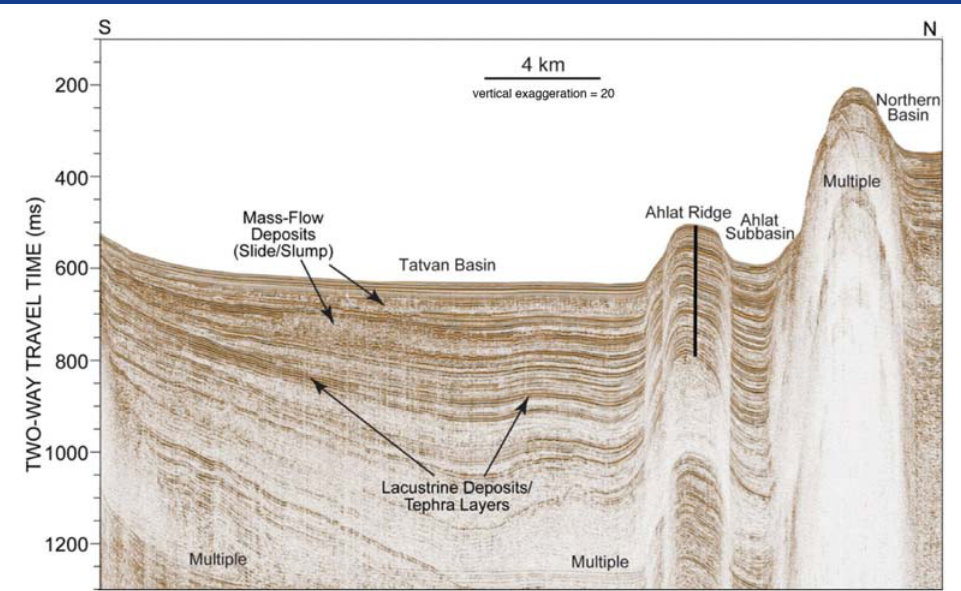
Figure 2. S eismic profile crossing the Tatvan Basin, Ahlat Ridge, and Northern Basin. Ahlat Ridge was selected as key site for the ICDP campaign in order to drill recover a complete sedimentary section for paleoclimatic investigations all the way to basement. S ee Fig. 1 for location of profile.